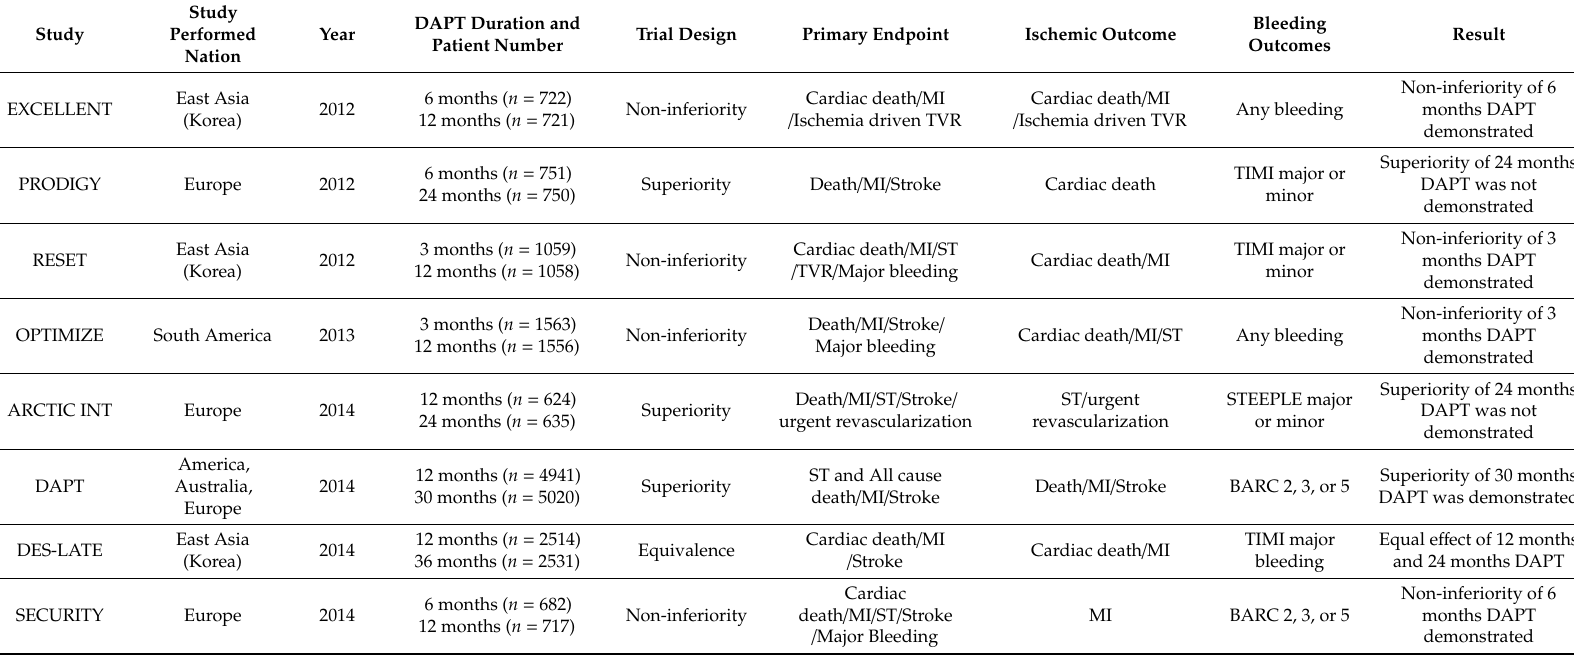
Table 1. Current large-scale randomized clinical trials (RCTs) comparing the e ffi cacy and safety of long-term and short-term dual antiplatelet therapy (DAPT).